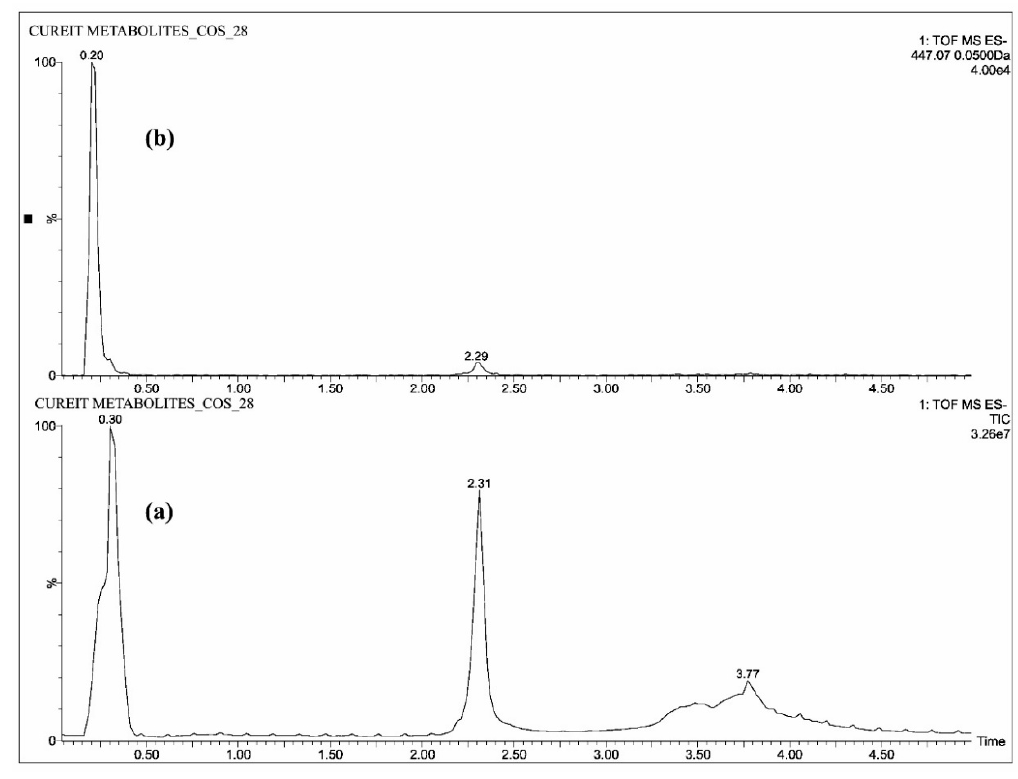
Figure 4. UPLC-QTOF-MS chromatograms of standard—( a ) total ion chromatogram of COS and ( b ) extracted ion chromatogram of COS.